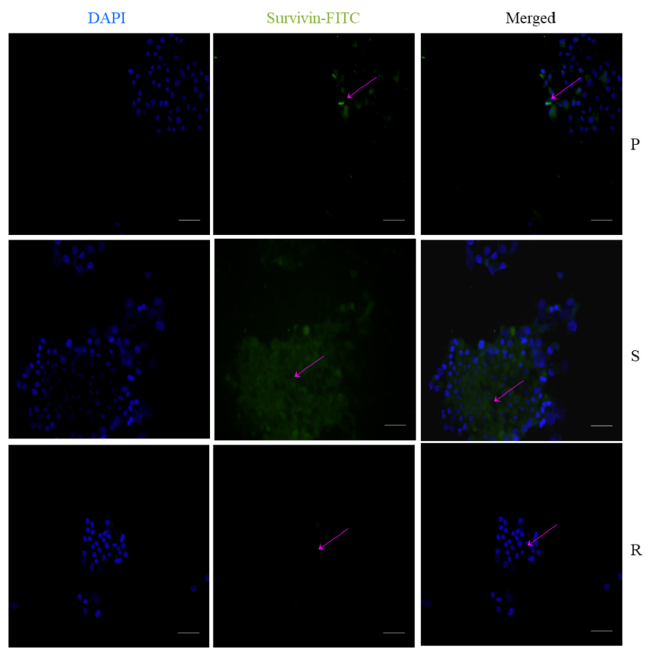
Figure 10. Expression of survivin by immunocytochemistry; survivin primary antibody stained with FITC and counterstained with DAPI. The scale bar indicates 20 μ m.